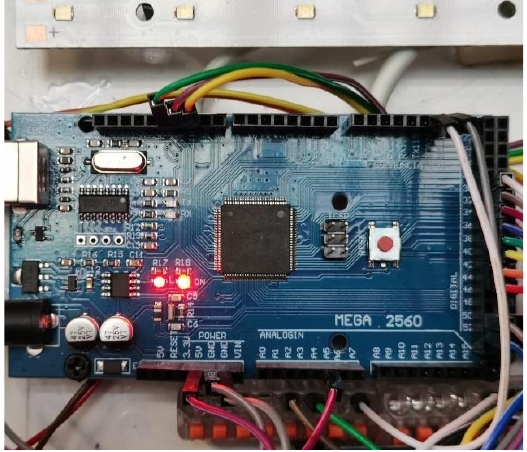
Figure 3. The main board of the autonomous parameter monitoring system.